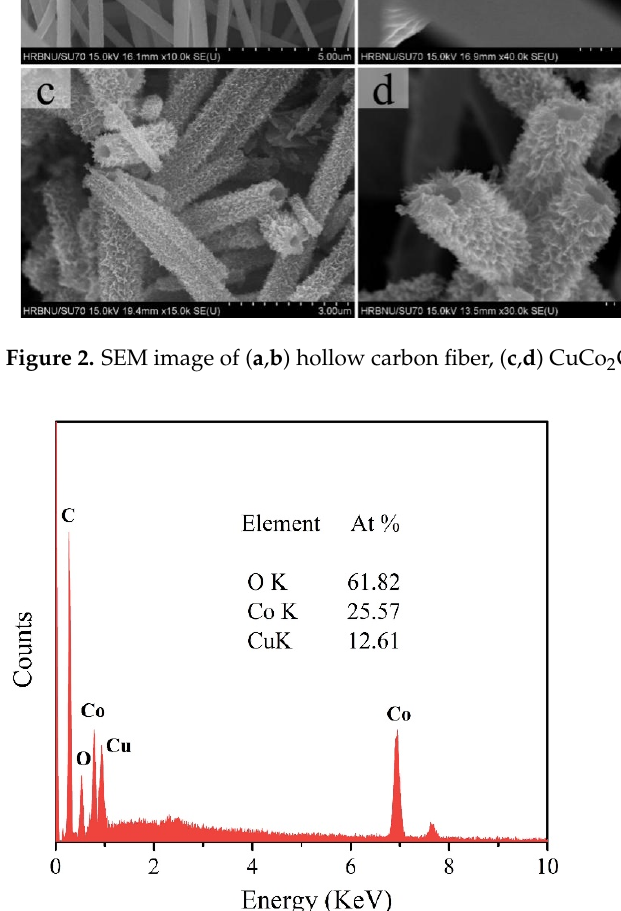
Figure 3. EDX spectrum of CuCo 2 O 4 @CNFs.